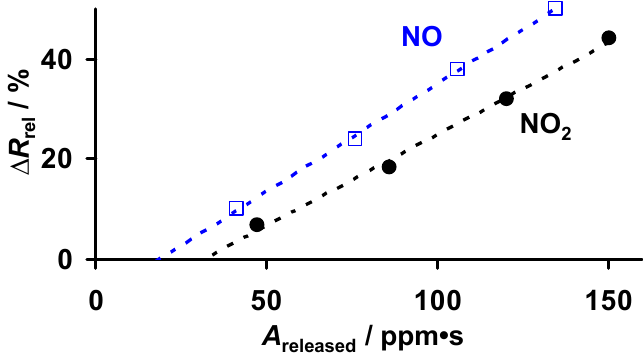
Figure 10. Correlation between the sensor response ∆ R the NO amount A obtained from subsequent x released